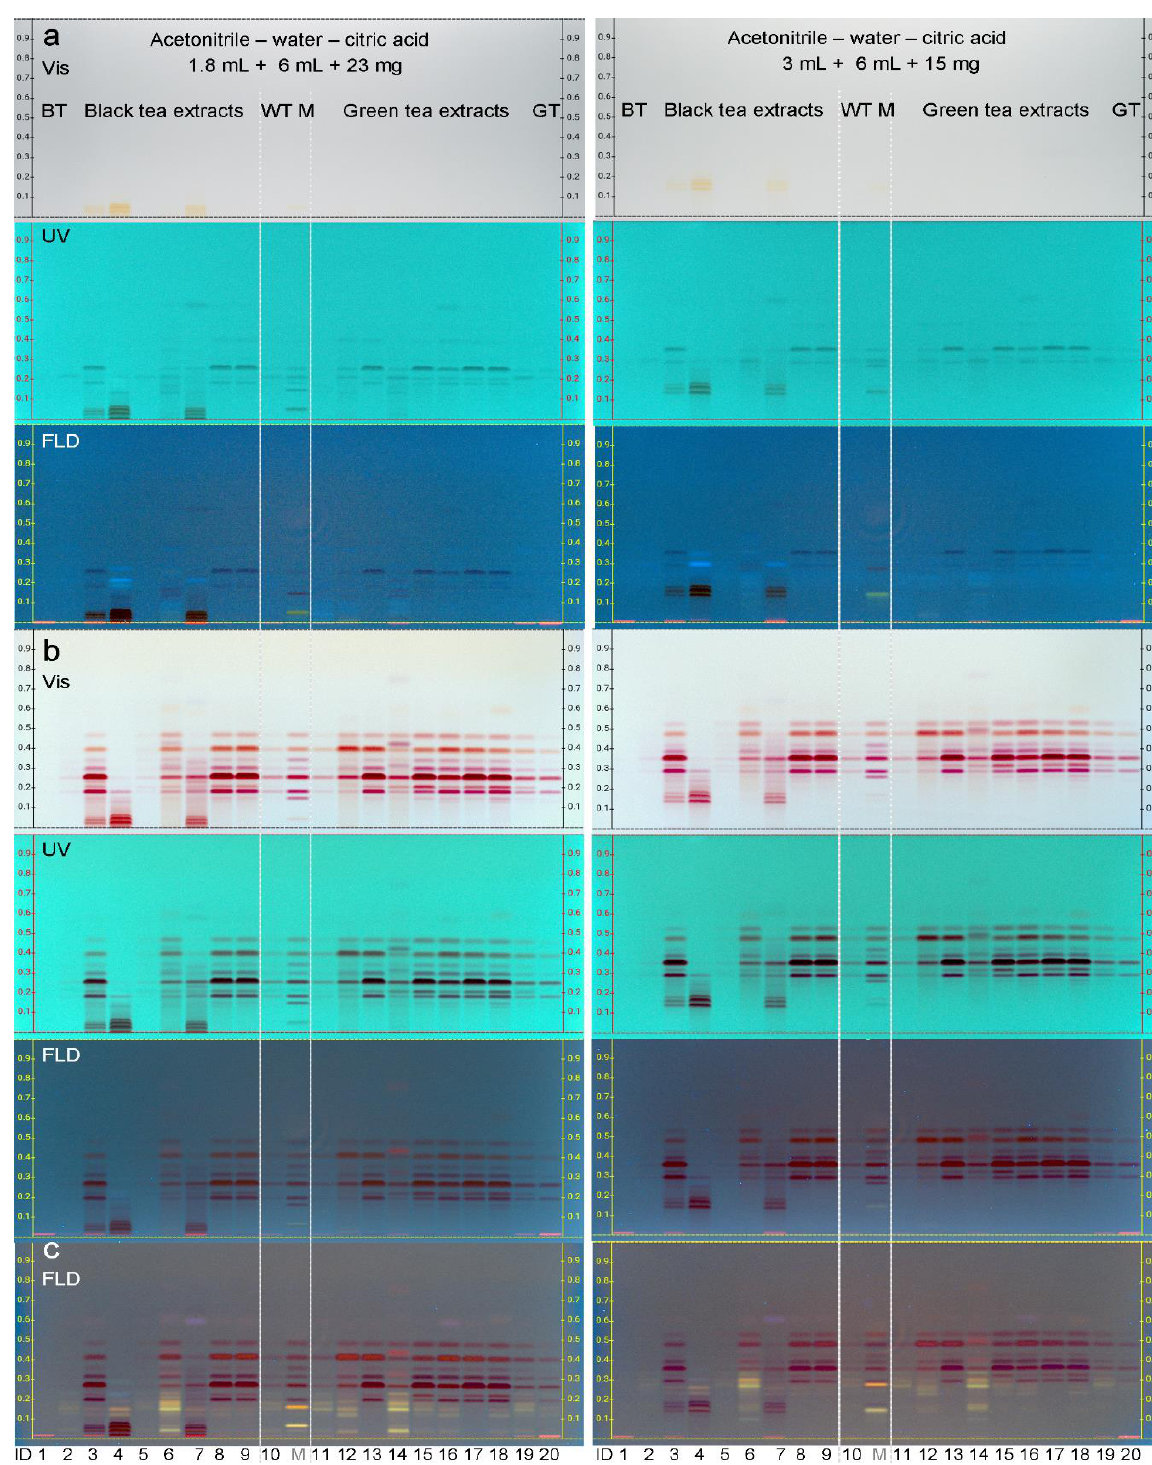
Figure 3. Physicochemical profiling: HPTLC–UV/Vis/FLD chromatograms of the 20 tea extracts (0.8 µL, 8 µg/band; black/white/green tea: BT/WT/GT; IDs in Table S1) and the 11-bioactive-compound mixture (M, 0.075–0.675 µg/band, depending on the individual compound amount, which was adjusted to the findings in the tea samples) separated on LiChrospher ® HPTLC plate silica gel 60 RP–18 WF 254 s using acetonitrile–water–citric acid (1.8 mL + 6 mL + 23 mg) versus (3 mL + 6 mL + 15 mg) before ( a ) and after reagent sequence of first Fast Blue B salt reagent ( b ); detection of 8 purple-red flavan-3-ols) and then natural product reagent ( c ); detection of yellow/orange fluorescent flavonols).